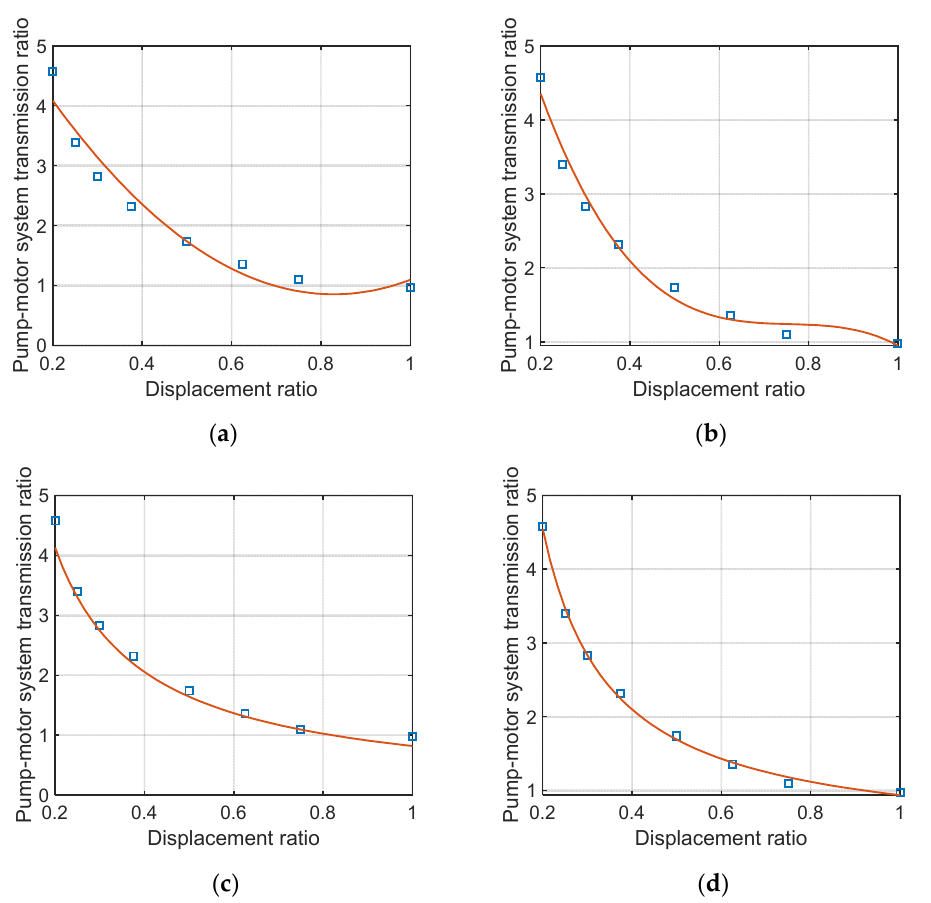
Figure 10. Correction results of speed regulating characteristics of variable-pump constant-motor system: ( a ) 2-order polynomial correction model; ( b ) 3-order polynomial correction model; ( c ) the first type of reciprocal correction model; ( d ) the second type of reciprocal correction model.